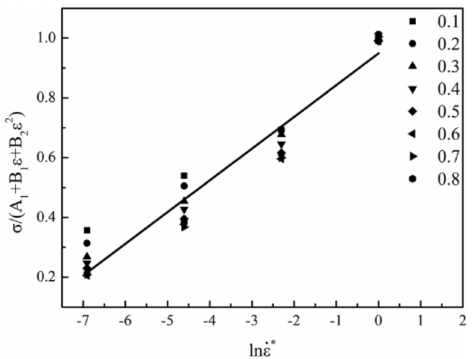
Figure 5. The relationship between stress and strain at 800 ◦ C and 1 s − 1 . The relationship between σ /( A ε + B ε 2 ) and ln . ε ∗ at 800 ◦ 1 + B 1 2